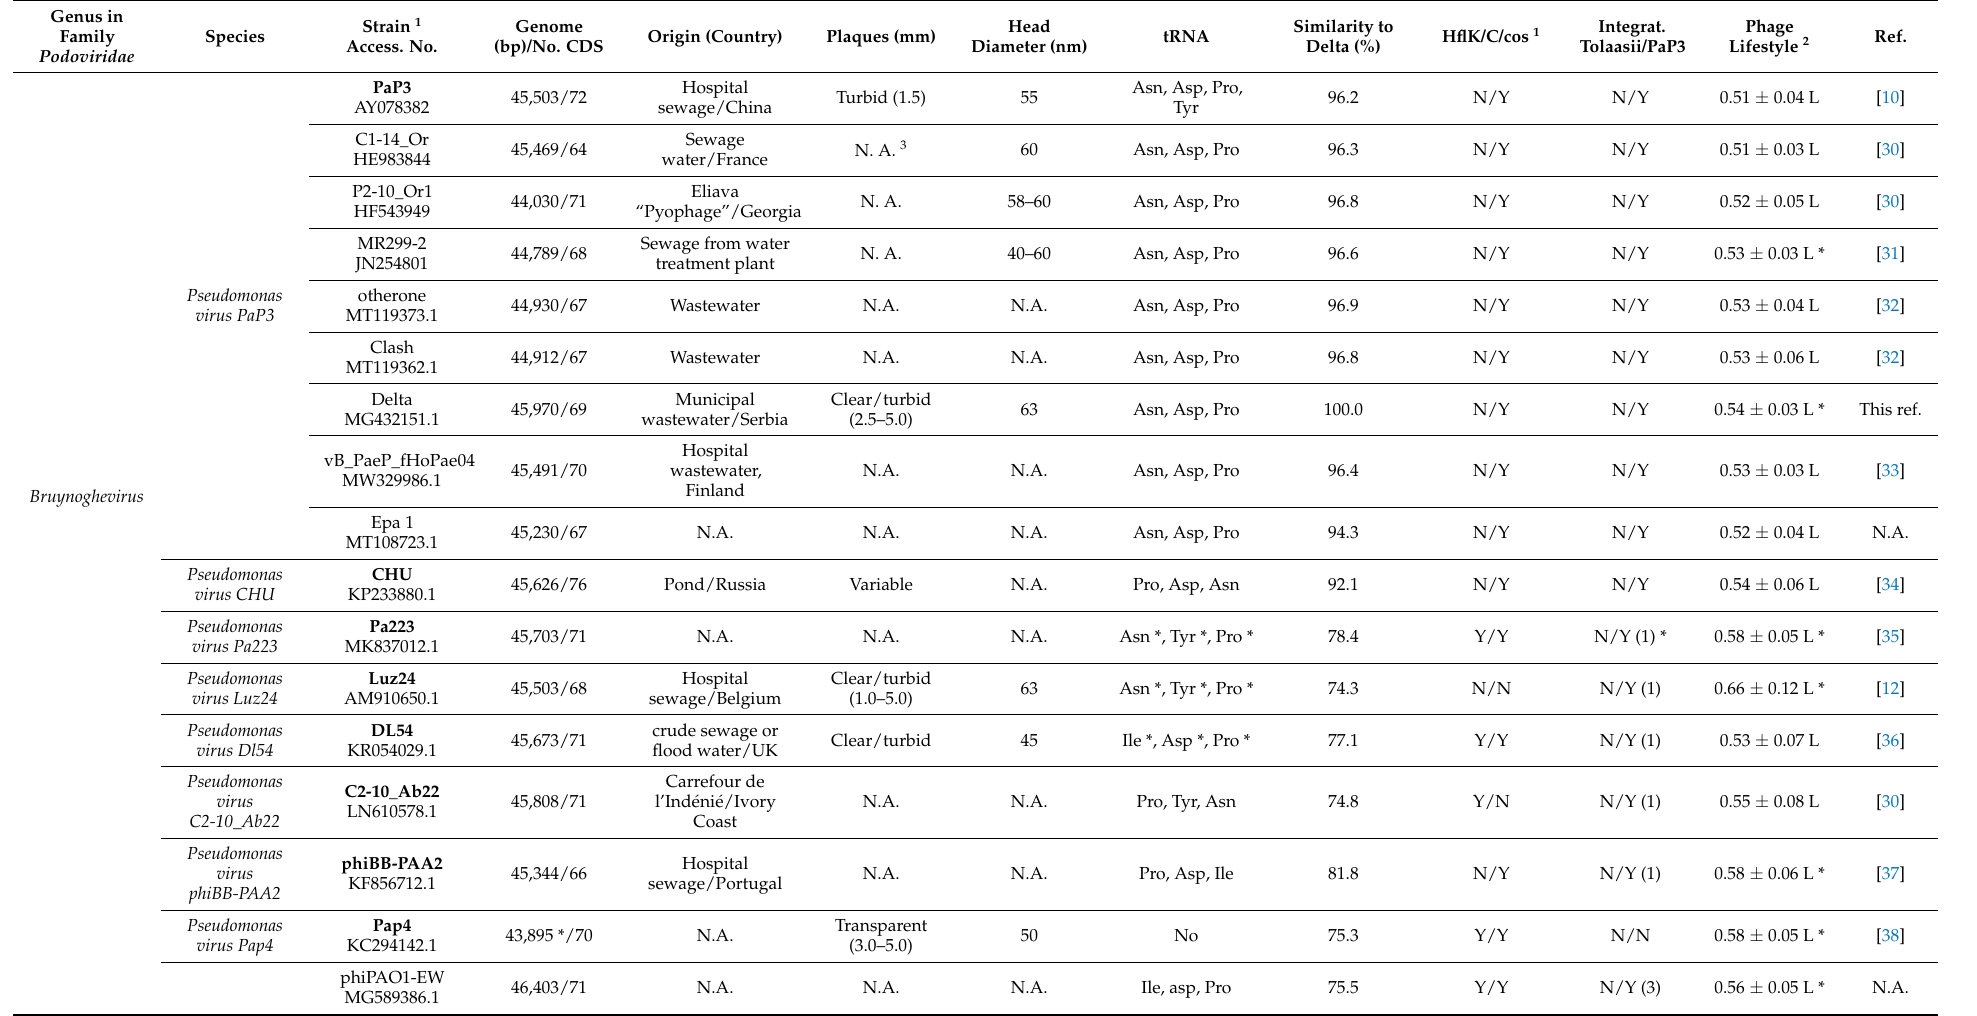
Table 1. Characteristics of Pseudomonas phage Delta and related